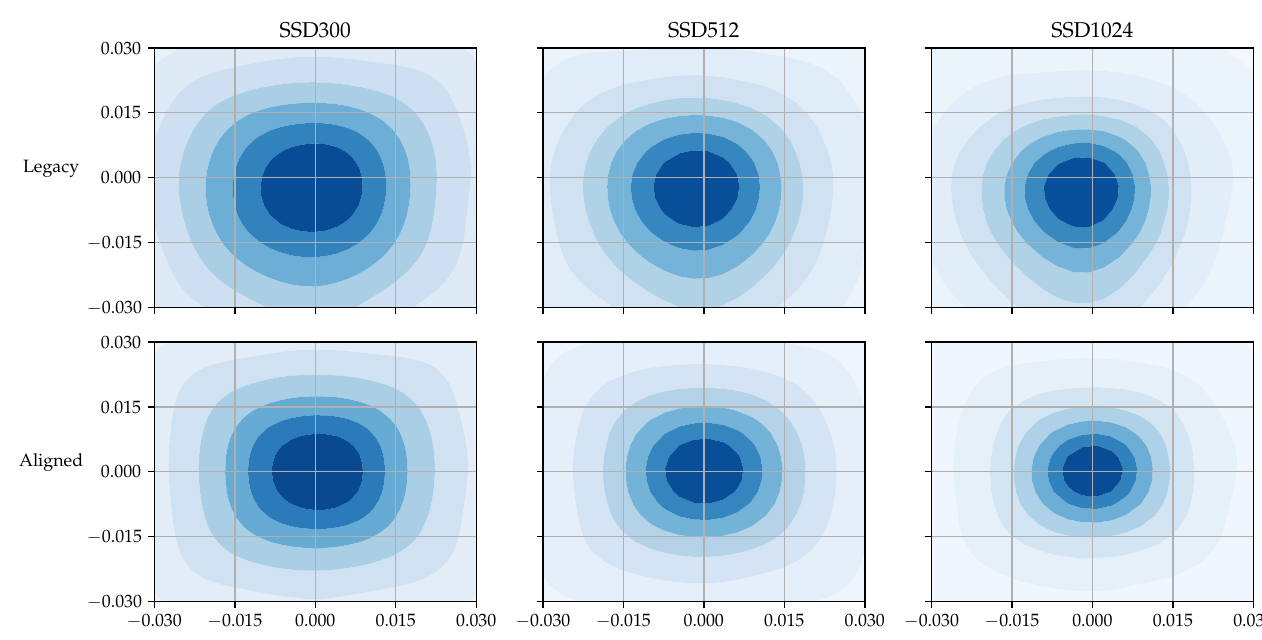
Figure 5. Relative center point distribution obtained from Pascal VOC.